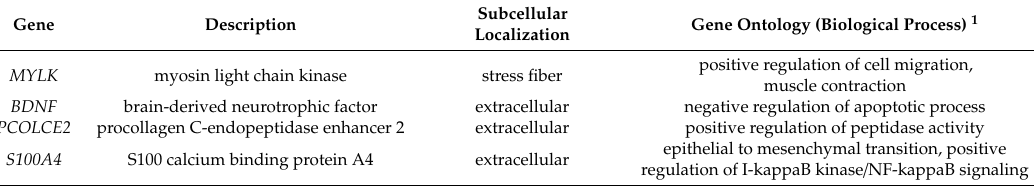
Table 3. The candidate genes upregulated in HMGA2-overexpressing DLD-1